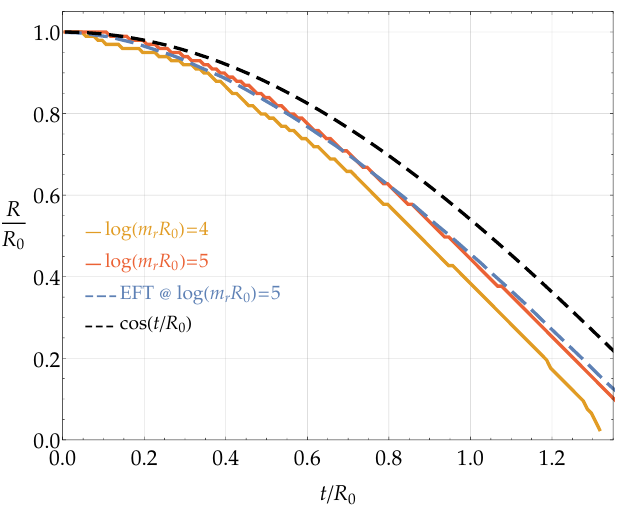
Figure 29 . Circular loop radius time-law R ( t ), normalised to the initial radius R 0 . Green and orange dashed lines correspond to the solution of the (cid:12)eld equations for log( m r R 0 ) = 4 ; 5. The solid blue line is the e(cid:11)ective (cid:12)eld theory prediction for log( m r R 0 ) = 5 and the solid black line